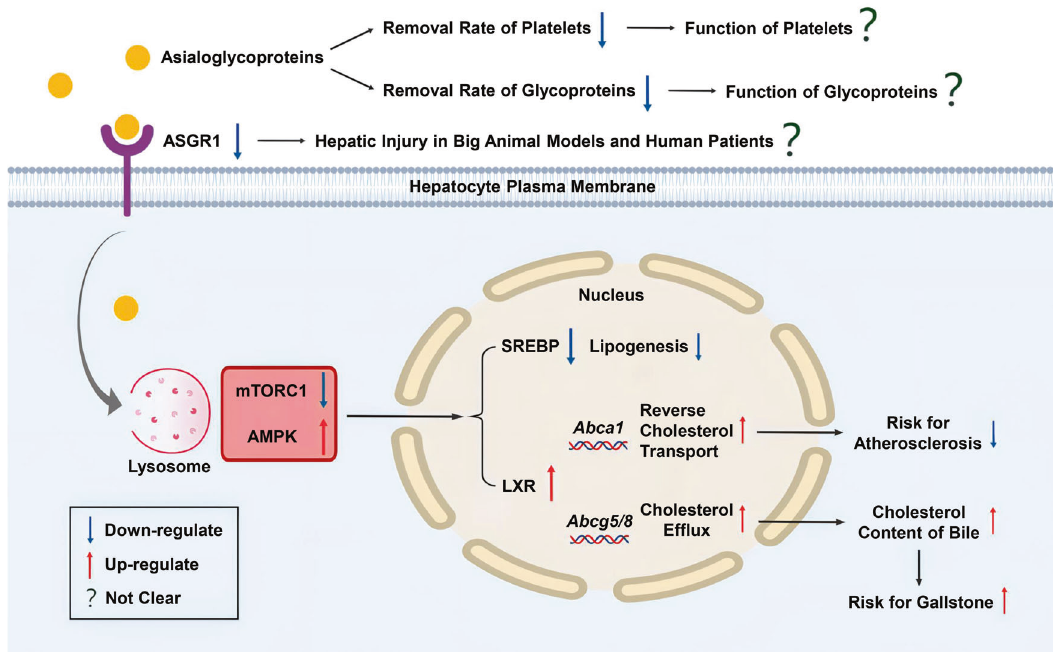
Fig. 1 Mechanism and possible effects of downregulation of ASGR1. Downregulation of ASGR1 results in the AMPK activation and the mTORC1 inhibition, which leads to the downregulation of SREBP and the upregulation of LXR and triggers a series of reactions in cholesterol metabolism. Besides, the removal rate of asialoglycoproteins is reduced, which may affect the clearance of old glycoproteins and platelets. Figure was created with Biorender.com